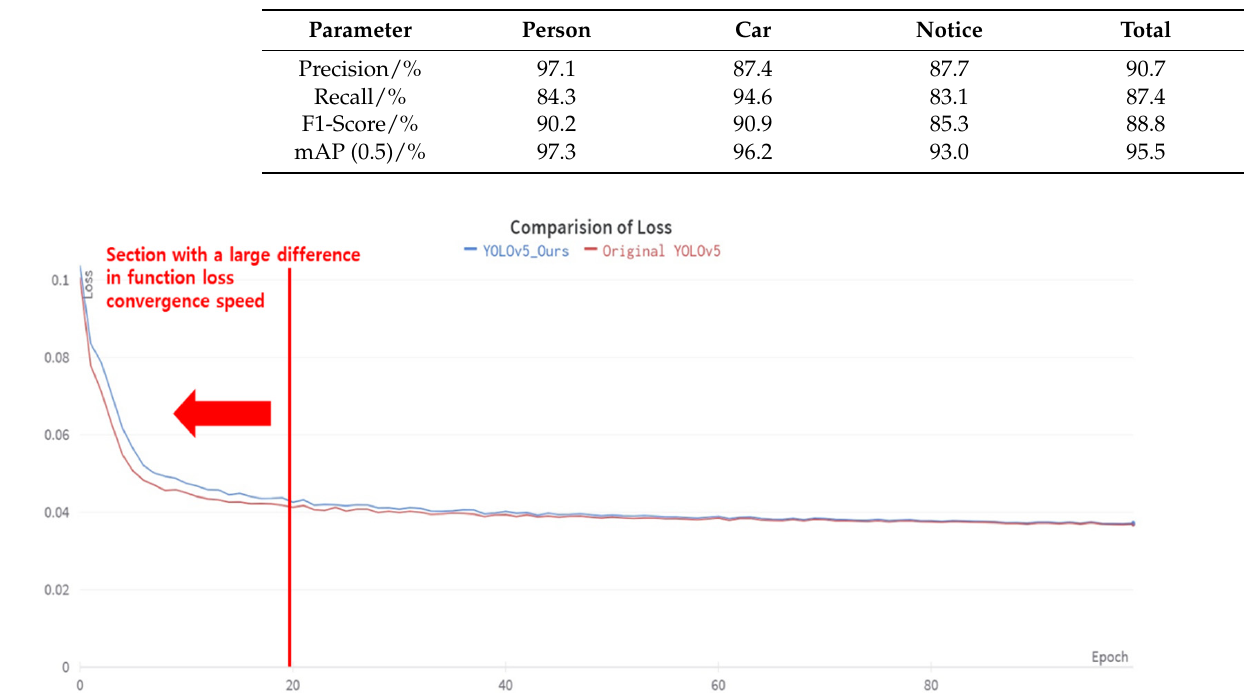
Figure 13. Detection result for the YOLOv5_Ours model ( Red is person, Orange is notice, and Pink is car). Table 3. Key indicators of YOLOv5_Ours model.